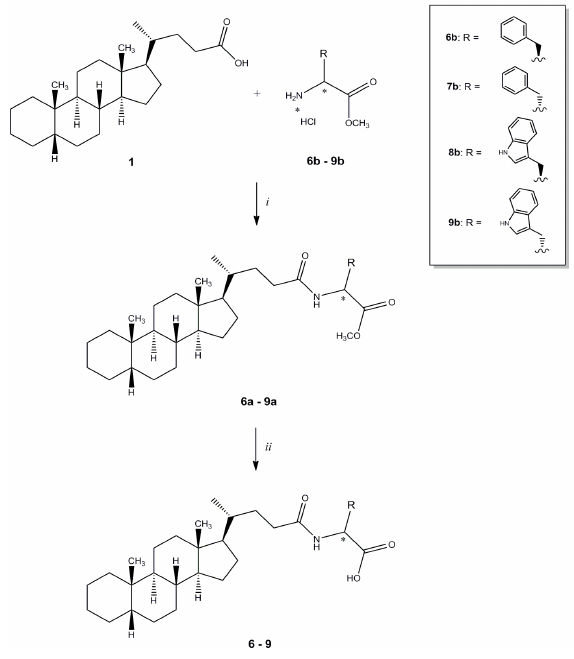
Scheme 2. General synthesis of compound 6 – 9 .